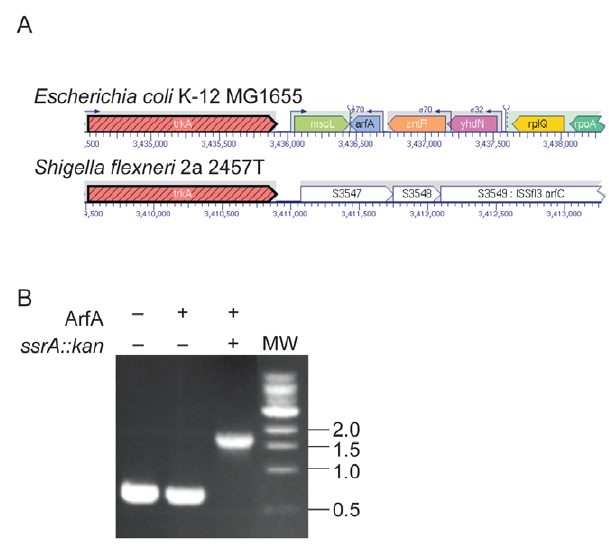
Figure 2. arfA accounts for phenotypic differences produced by deleting ssrA in E.coli and S.flexneri. ( A ) arfA (blue) in Escherichia coli K-12 MG1655 and the corresponding locus in Shigella flexneri 2a 2457T, aligned using EcoCyc Pathway Tools (SRI International). ( B ) Diagnostic PCR reactions of genomic DNA prepared from wild-type S. flexneri (lane 1), S. flexneri pCA24N-His 6 -ArfA (lane 2), and S. flexneri ssrA::kan pCA24N-His 6 -ArfA (lane 3). The expected product size for wild- type ssrA is 0.6 kb and for ssrA::kan is 1.7 kb. Molecular weight markers with sizes in kb are indicated.